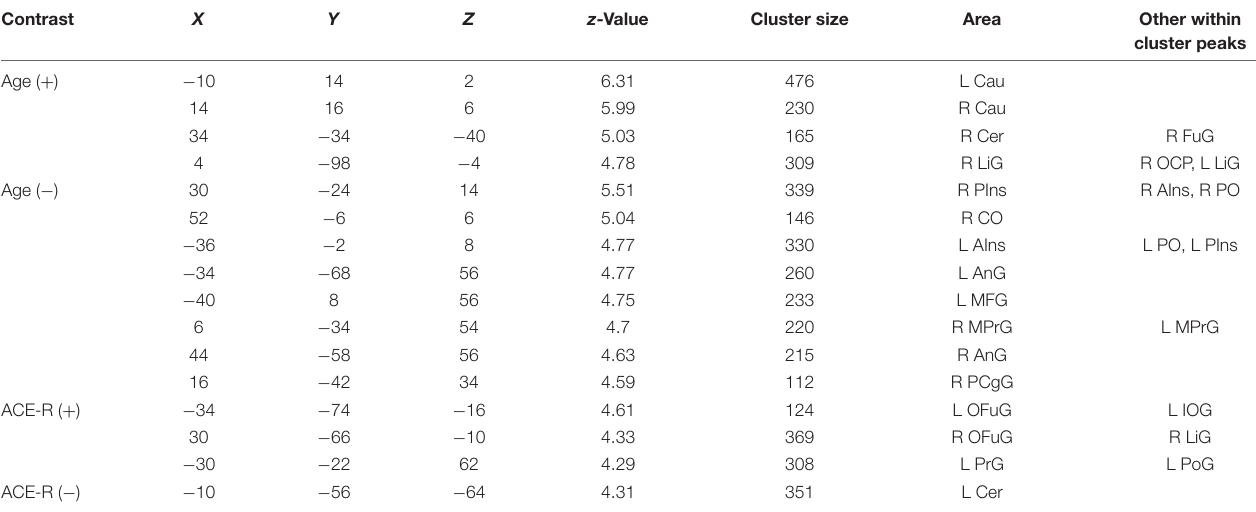
TABLE 4 | Regions showing significant (FWEc p < 0.05, CDT p = 0.001) relationship between long-range ICC values and age and ACE-R total score.